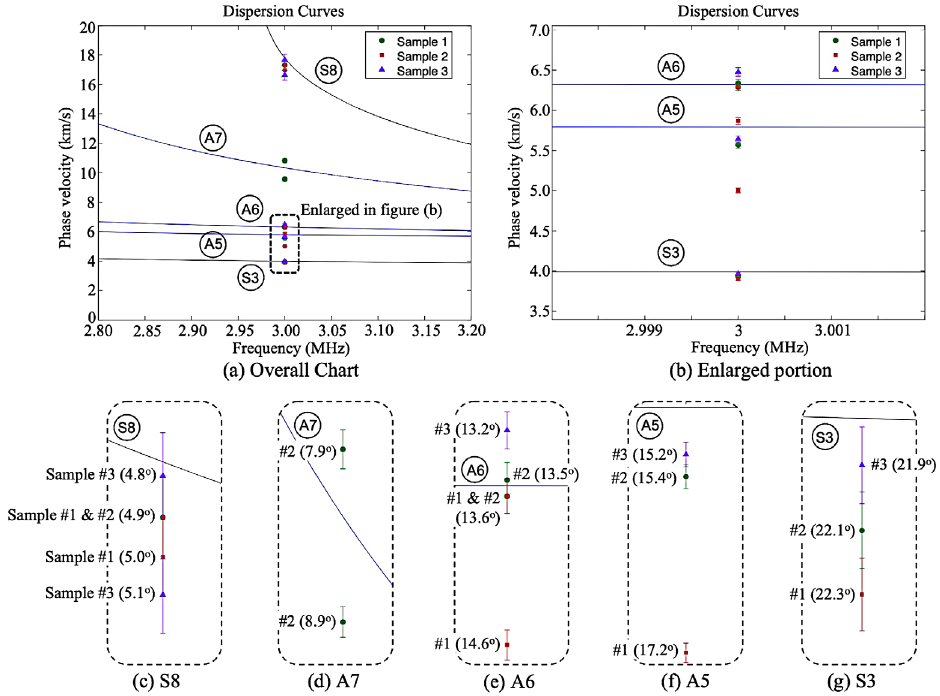
Figure 6. (a) The points along f = 3 MHz indicate the velocities at the angle of incidence where the Schoch effect appears. The error bars represent the estimated errors by measurement uncertainties (0.1 (cid:3) for the angle and 1 m/s for the sound velocity in water). (b) The enlarged area around A6, A5, and S3, for the clarity of points ’ locations. (c) to (g) Further magni fi cation shows snapshots of groups of points predicted to correspond to each mode. Note that in fi gures (c) to (g), the plots are not to scale in terms of velocity (vertical) axis from one snapshot to the other since the primary purposes are to show the relative positions of points and the variance of the angle of incidence at which the Schoch effect appears.